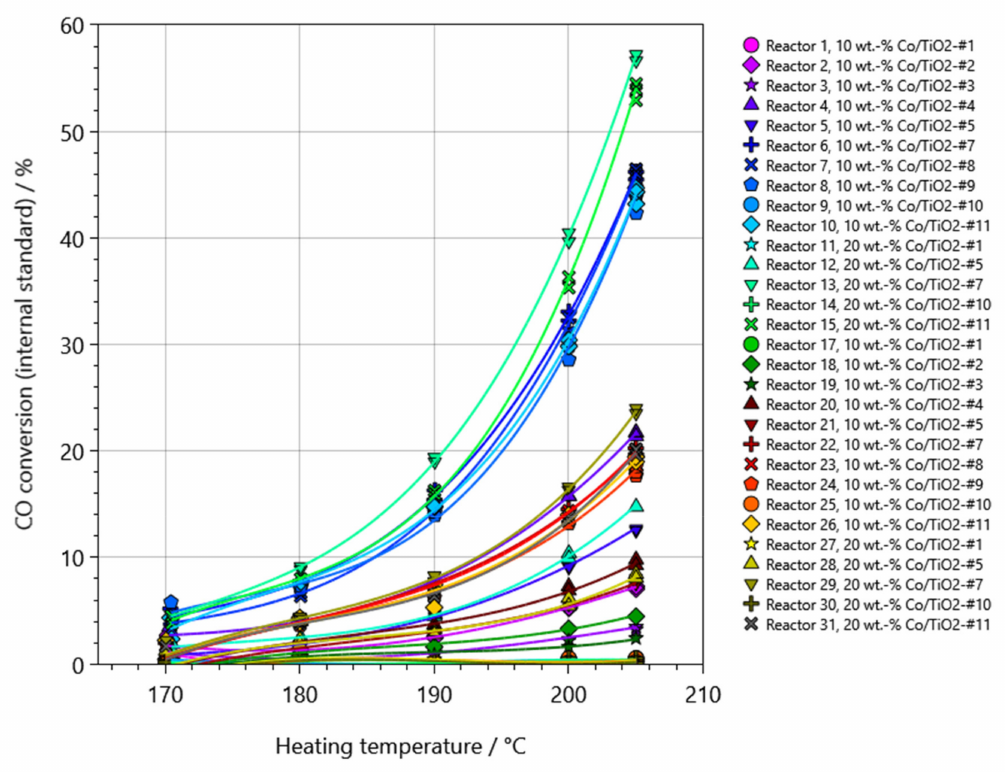
Figure 7. Conversion of CO as a function of reactor temperature.